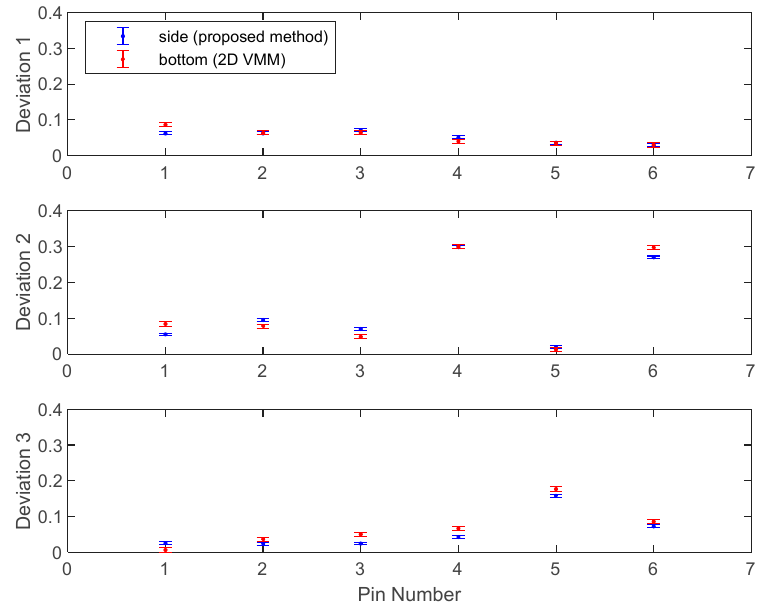
Figure 9. The image of the peg and pins was captured by the camera in the view direction: ( a ) θ b 1 = 7 ◦ , and ( b ) θ b 2 = − 7 ◦ . The red lines, which will be used to calculate the deviations, represent the centers of the peg and pins. Table 2. The deviations of the first six pins of the three samples measured in case study two. “Side” means that the measurement was performed from the side of the samples using the proposed method, and “bottom” means that the measurement was performed from the bottom of the samples using the 2D VMM.